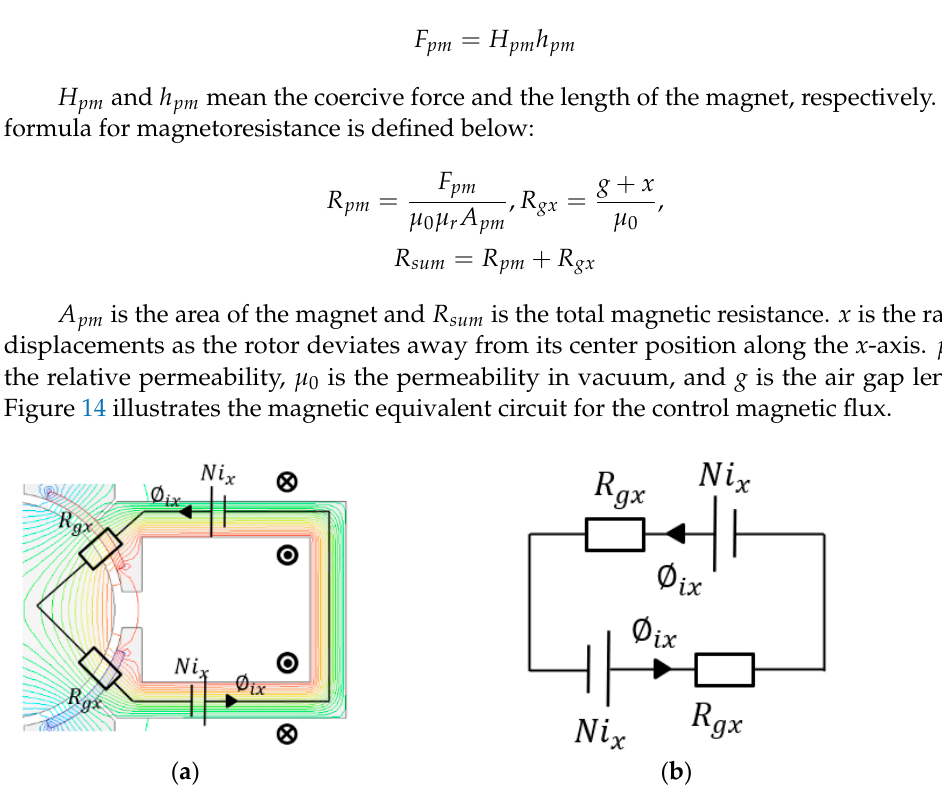
Figure 14. Magnetic equivalent circuit of the control magnetic flux of the HSTMB: ( a ) magnetic equivalent circuit and ( b ) the simplified magnetic equivalent circuit.